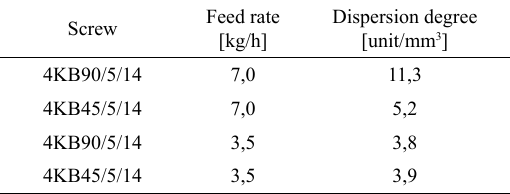
Table 3. Dispersion degree of the ABS particles in the PBT matrix as function of the angle between the kneading blocks disks and the feed rate of the blends, obtained with extrusion die land of 2.00 mm and speed rotation of 120. Feed rate Dispersion degree Screw [kg/h] [unit/mm 3 ] 4KB90/5/14 7,0 11,3 4KB45/5/14 7,0 5,2 4KB90/5/14 3,5 3,8 4KB45/5/14 3,5